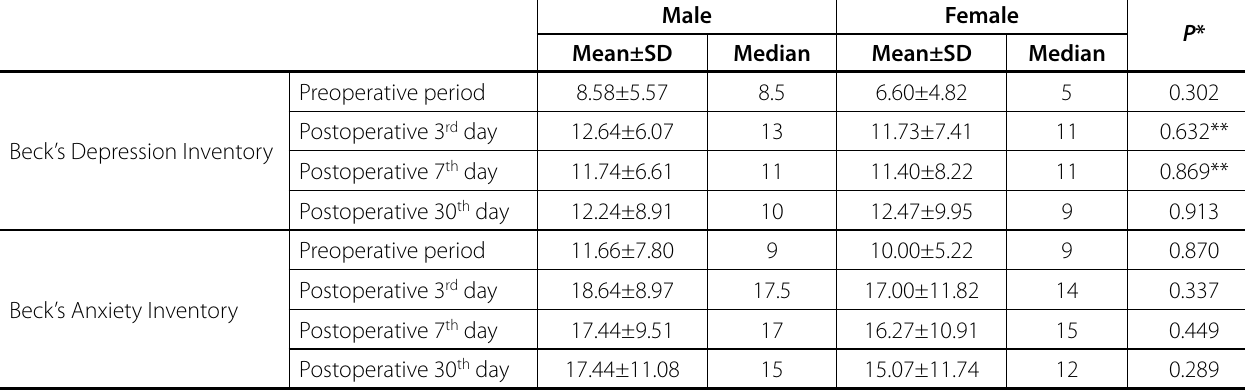
Table 6 . Statistical correlation between gender and Beck’s depression and Beck’s anxiety test values (no significant value; P